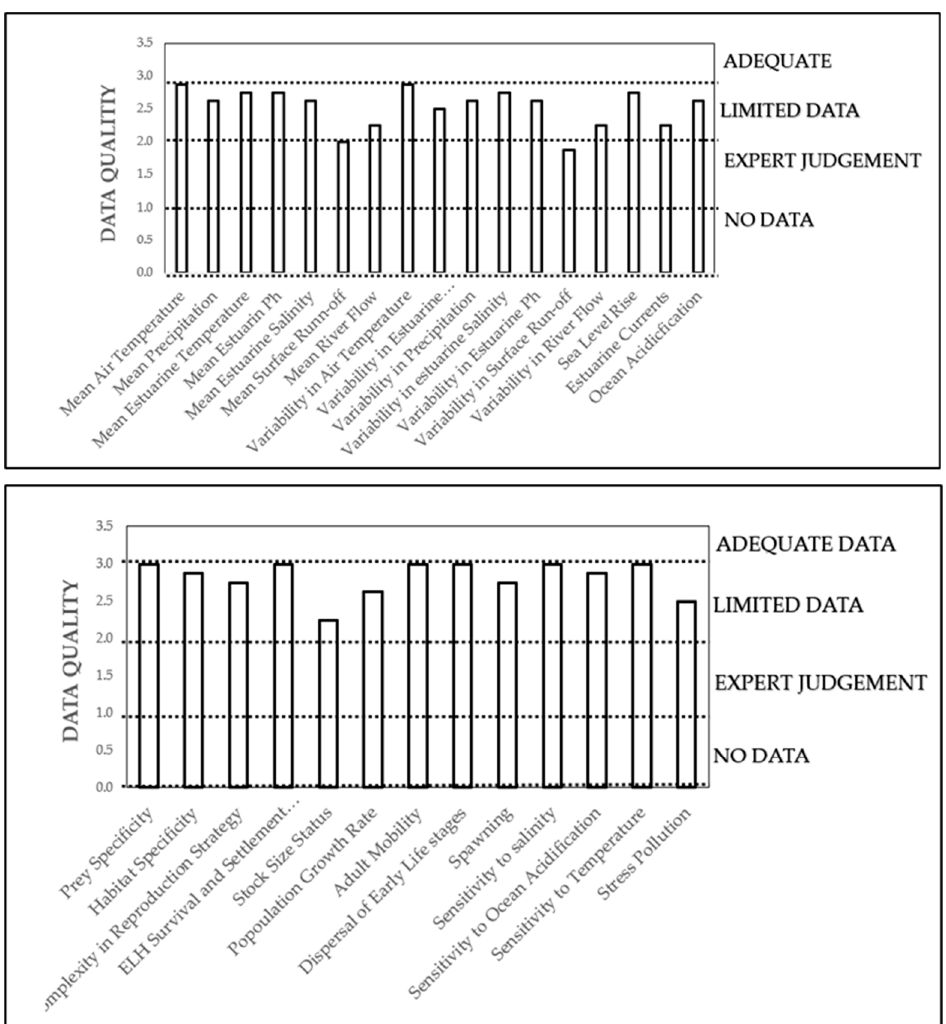
Figure 3. Quality of data used in assessing the vulnerability of C. tulipa . (3 depicts adequate data, 2 depicts limited data, 1 depicts data based on expert knowledge and 0 depicts no available data).